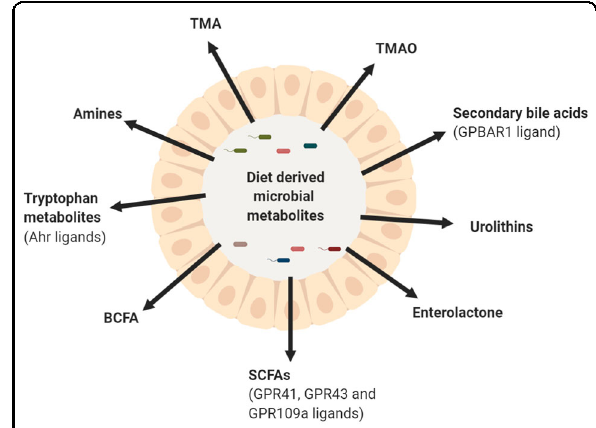
Fig. 1 Diet-derived microbial metabolites. Intestinal microbiota can secrete diet-derived metabolites, which can potentially activate the immune system through Ahr, GPRs or GPBAR1. Ahr Aryl hydrogen receptor, BCFA branched chain fatty acid, GPBAR1 G protein – coupled bile acid receptor 1, GPR G-protein-coupled receptor, SCFA short- chain fatty acids, TMA trimethylamine, TMAO trimethylamine